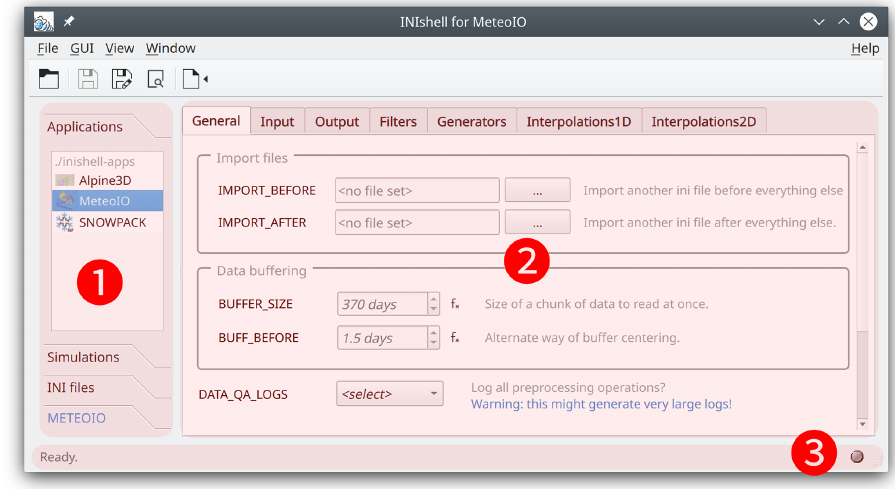
Figure 4. Overview of the Inishell software with the MeteoIO numerical model profile loaded (here on Linux with the light theme).